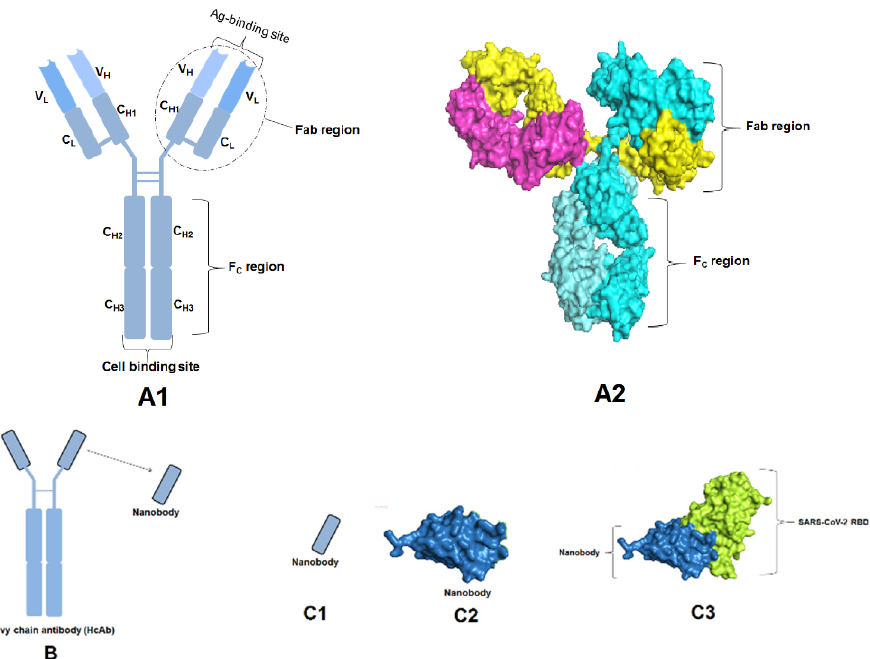
Figure 8. Structure of heavy chain antibodies and its parts. ( A1 ) Schematic structure depicted different parts. ( A2 ) Surface structure shows Fc and Fab region. ( B ) Heavy chain antibodies along with the nanobody. ( C ) Nanobody complex with the SARS-CoV-2 RBD.